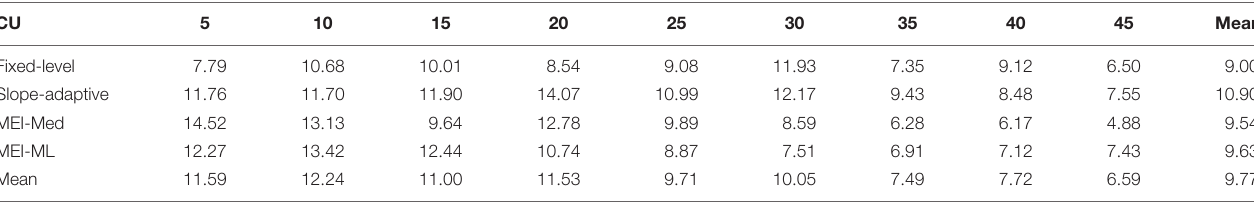
TABLE 1 | Standard deviations of sound pressure level (SPL) for each categorical unit (CU) for participants with normal hearing for each of the four CLS procedures at 1 kHz.